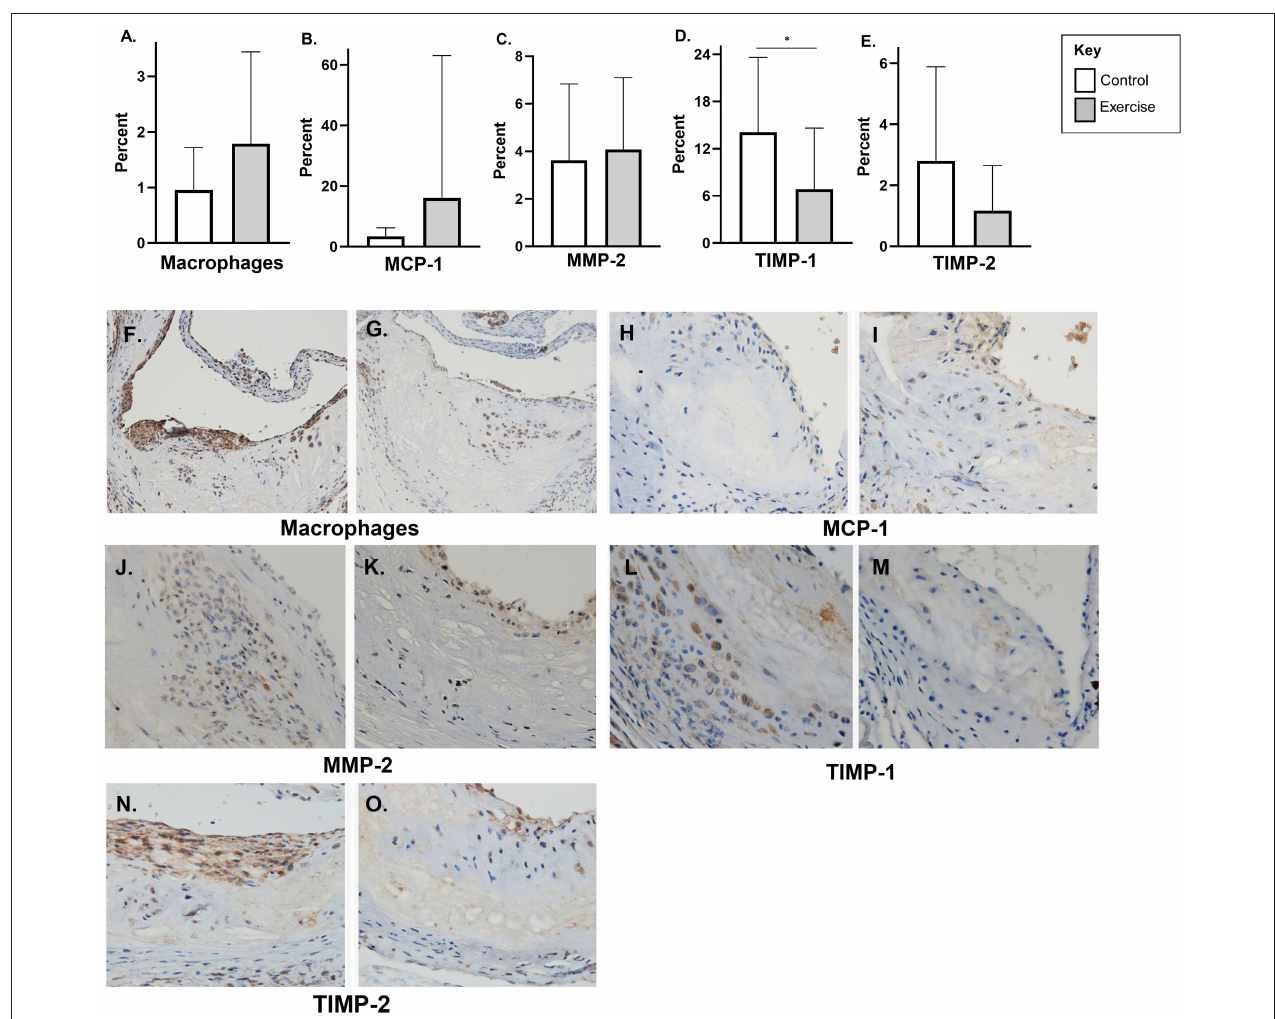
FIGURE 5 | The effect of exercise on F4/80, MMP-2, TIMP, and MCP-1 levels in a late-stage model of atherosclerosis. Chow fed apoE -/- mice with late-stage plaques were exposed to exercise for 10 weeks at 40 weeks of age. Aortic sinus sections were assessed for plaque content of (A) macrophages (F4/80%), (B) monocyte chemoattractant protein-1 % (MCP-1) (C) matrix metalloproteinase-2 % (MMP-2), (D) tissue inhibitor of metalloproteinase-1 % (TIMP-1), and (E) tissue inhibitor of metalloproteinase-2 % (TIMP-2). Data are expressed as mean ± SD. The x -axis represents the control (white bar) vs. the exercise group (gray bar). Representative sections of the aortic sinus with stains for macrophage content (F4/80) [ (F) control, (G) exercise], MCP-1 [ (H) control, (I) exercise], MMP-2 [ (J) control, (K) exercise], TIMP-1 [ (L) control, (M) exercise], and TIMP-2 [ (N) control, (O) exercise], with magnification x 600. * p <